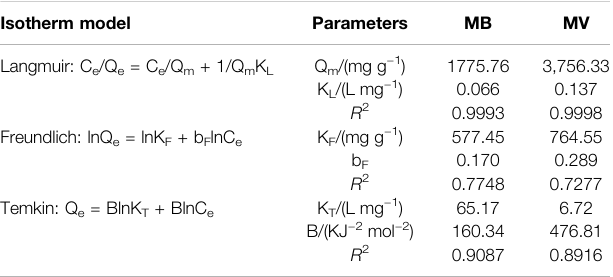
TABLE3| AdsorptionisothermparametersfortheadsorptionofMBandMVonto the PFPCS at pH (cid:2) 8 and 25 ° C. The contact time was 60 min. Isotherm